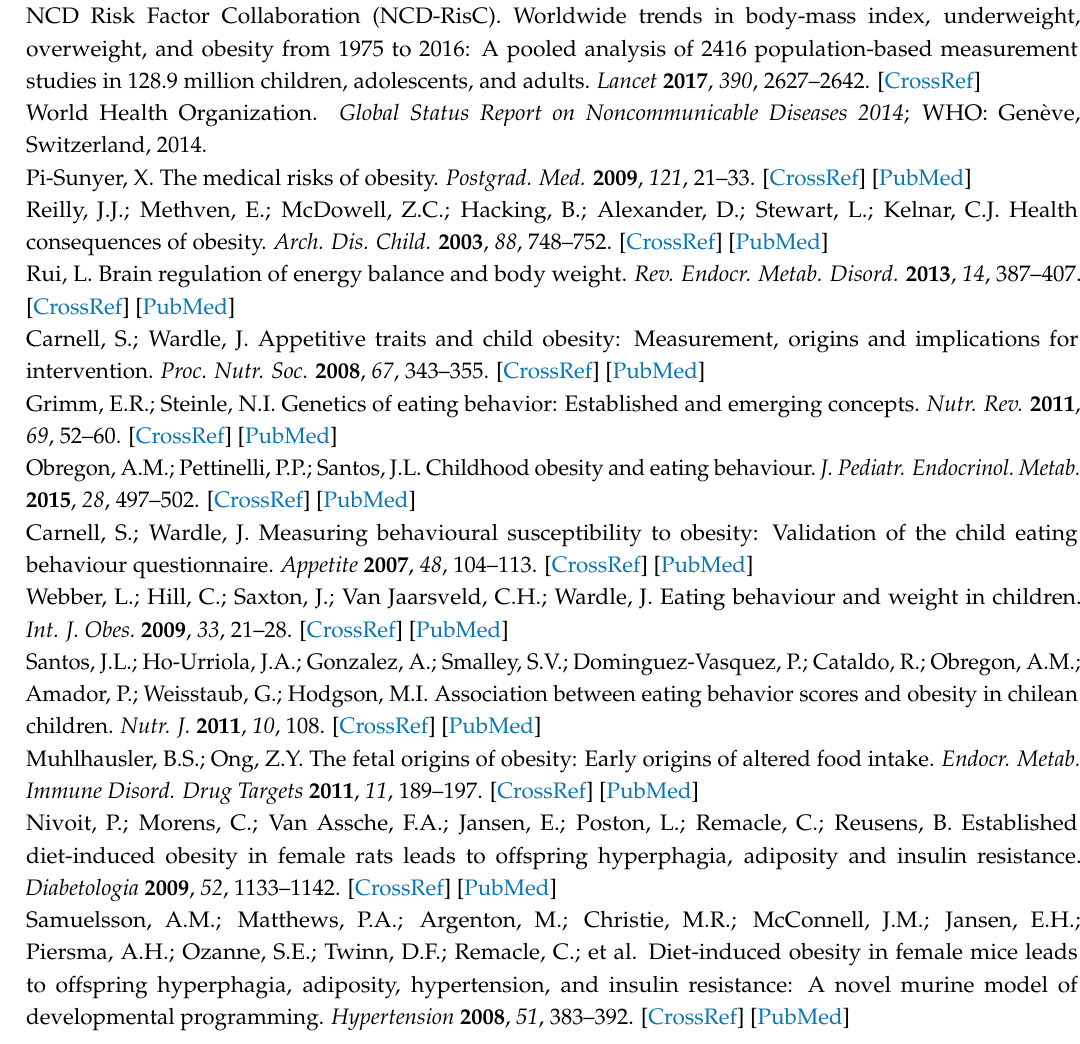
s1, Table S1: Non-response analysis, Table S2: CEBQ scores according to maternal and offspring characteristics, Table S3: Secondary analysis; Association between prenatal maternal lipid profile and offspring’s eating behaviour at age 5, Table S4: Secondary analysis; Association between prenatal maternal lipid profile and offspring’s food intake at age